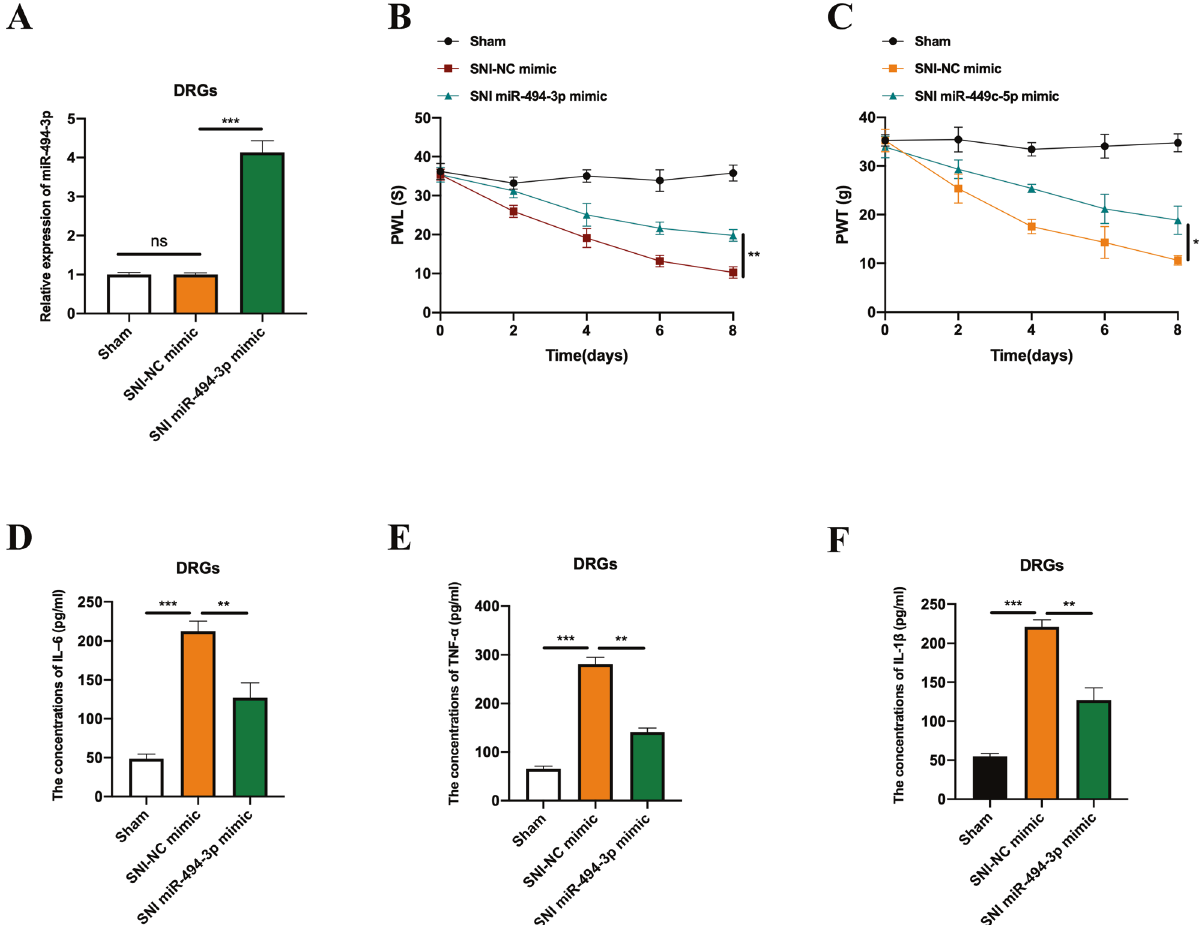
Fig. 5 MiR-494-3p attenuates SNI-induced neuropathic pain. A The relative expression level of miR-494-3p, in the DRGs from SNI rats pre- intrathecally injected with NC mimic and miR-494-3p mimic was measured by qRT-PCR. B PWL and ( C ) PWT assays were performed to assess the neuropathic pain of rats from the sham and miR-494-3p overexpressed SNI groups. The levels of IL – 6 ( D ), TNF – α ( E ), and IL-1 β ( F ) in the DRGs of rats from the sham and miR-494-3p overexpressed SNI groups were assessed by ELISA assay. Experimental data are presented as mean ± SD. ** P < 0.01, *** P <